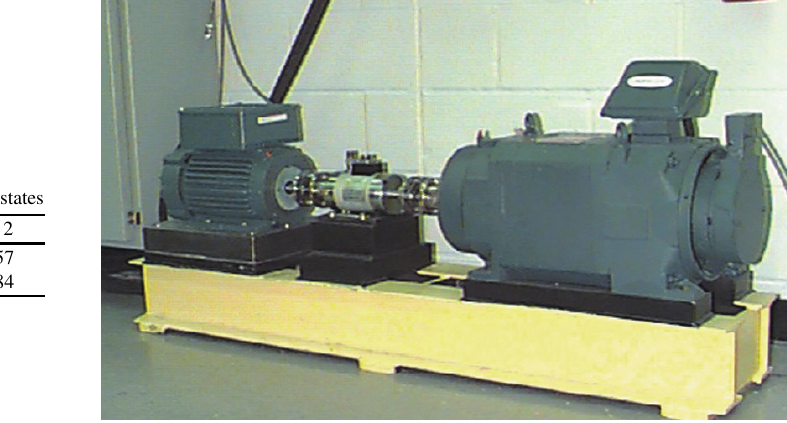
Fig. 4. The experimental apparatus of bearing fault diagnosis.